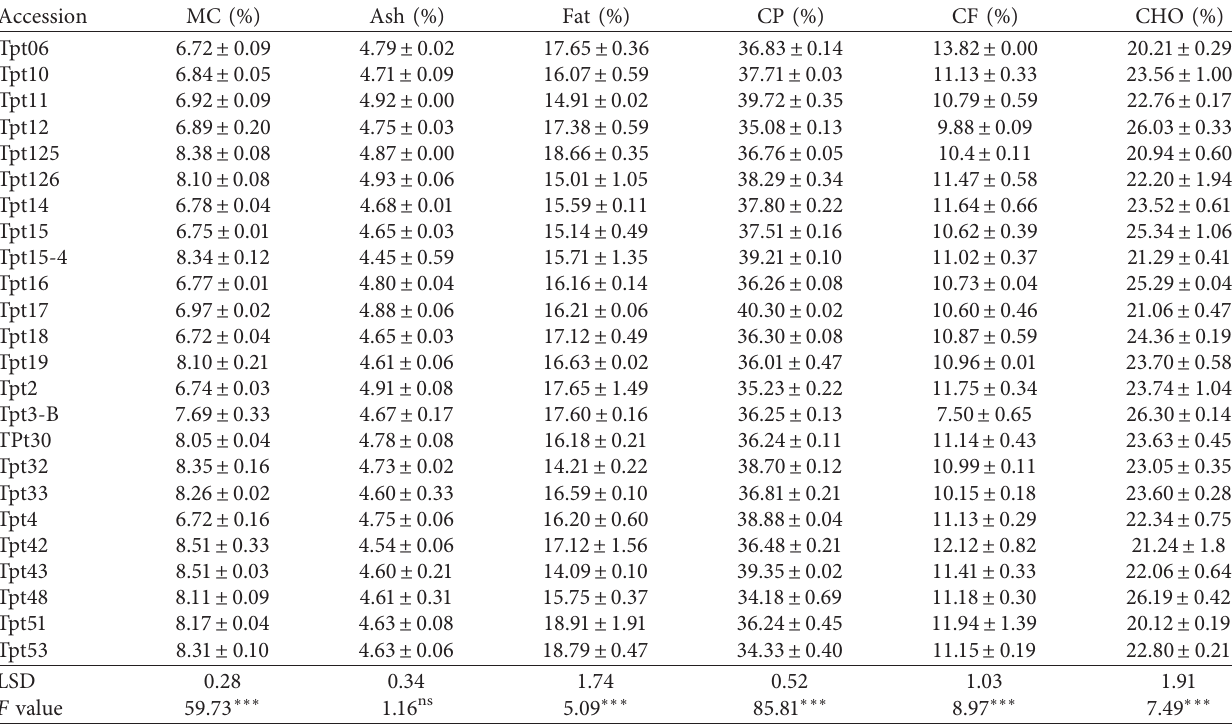
Table 2: Proximate composition (mean ± standard deviation) of processed seeds of winged bean.